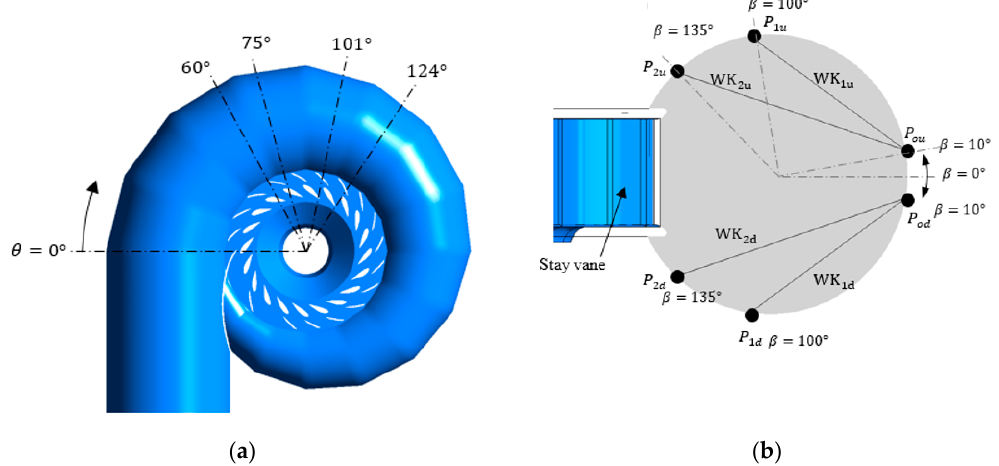
Figure 2. ( a ) Locations of the Winter–Kennedy (WK) configurations at four cross-sections along the azimuthal direction of the SC at θ = 60°, 75°, 101°, and 124°; ( b ) WK pressure points marked with the black circles and combinations represented by the solid lines for each cross-sectional plane. The angular locations of the pressure points on the plane are given by β angles, which are referenced from β = 0°.